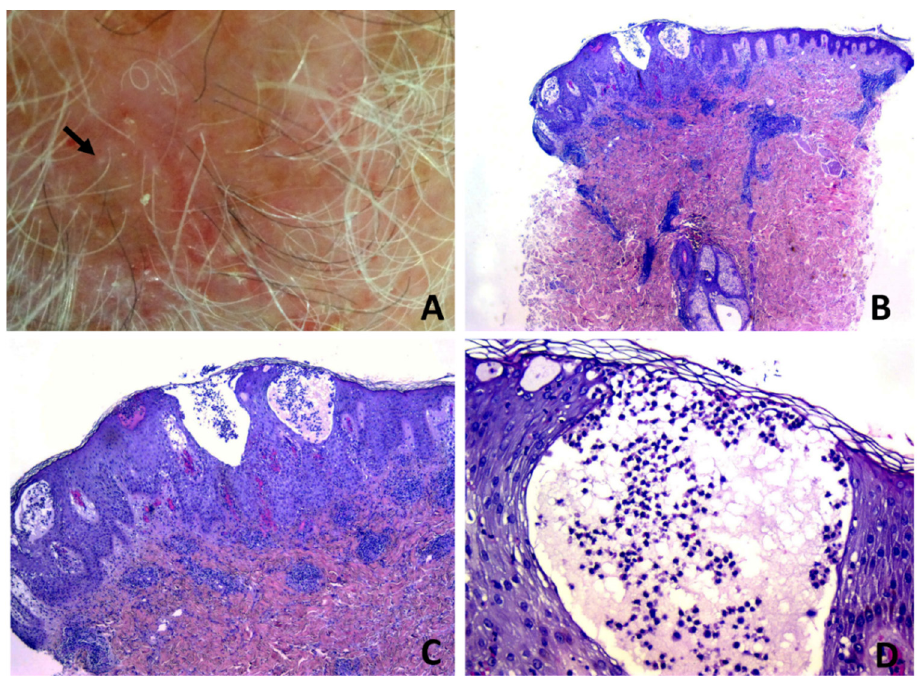
Figure 4. Erosive pustular dermatosis of the scalp; ( A ) follicle-based vesiculo-pustules and erosions; ( B , C ) vesiculo-pustules at top of follicular orifices, with sparing of interfollicular epidermis; ( D ) the vesicle contains numerous polymorphonuclear cells.